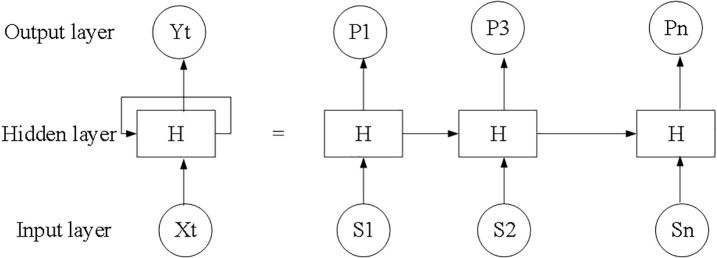
Construction of translation model based on RNN.